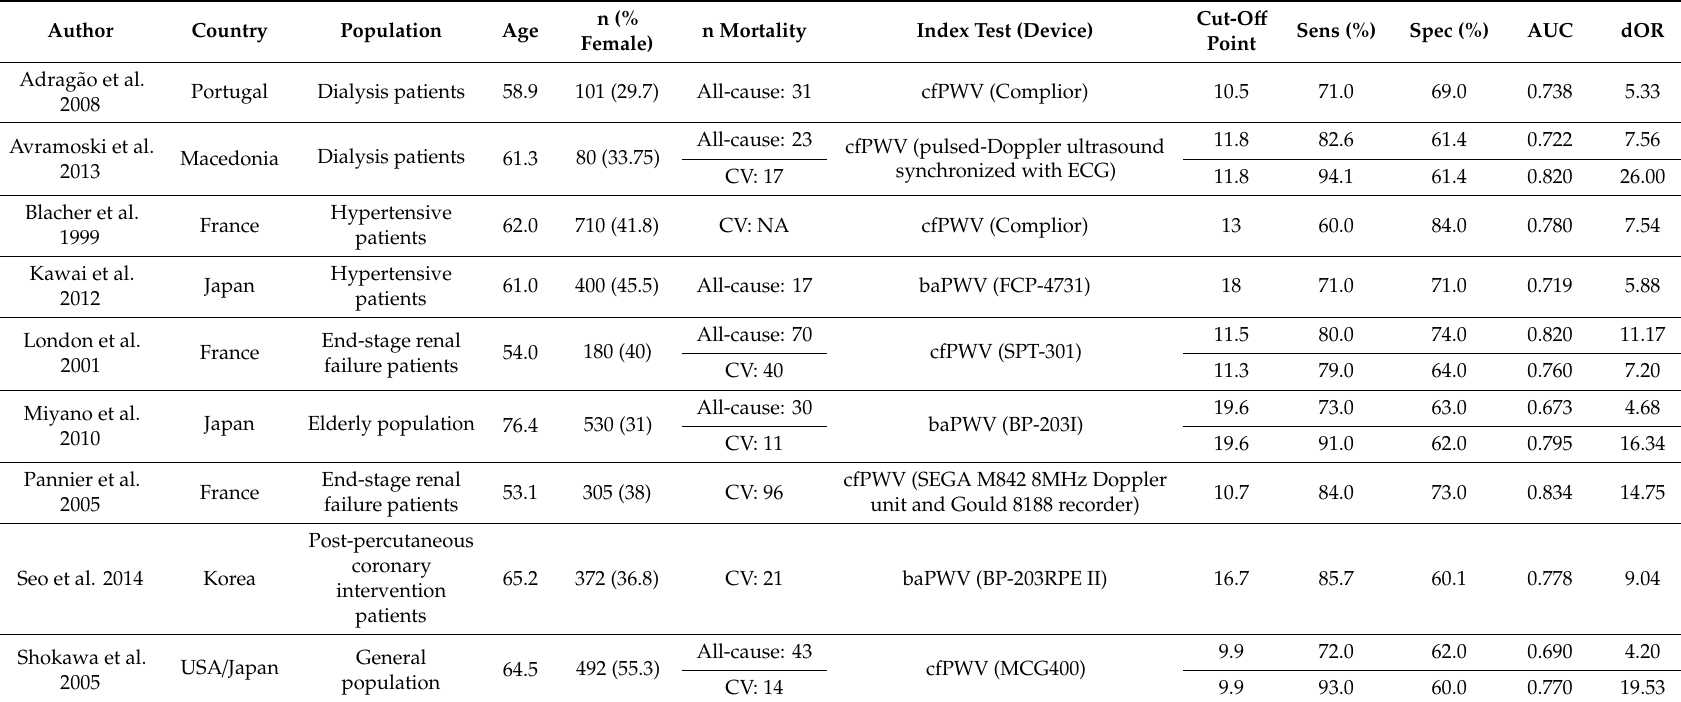
Table 2. Characteristics of studies included in the